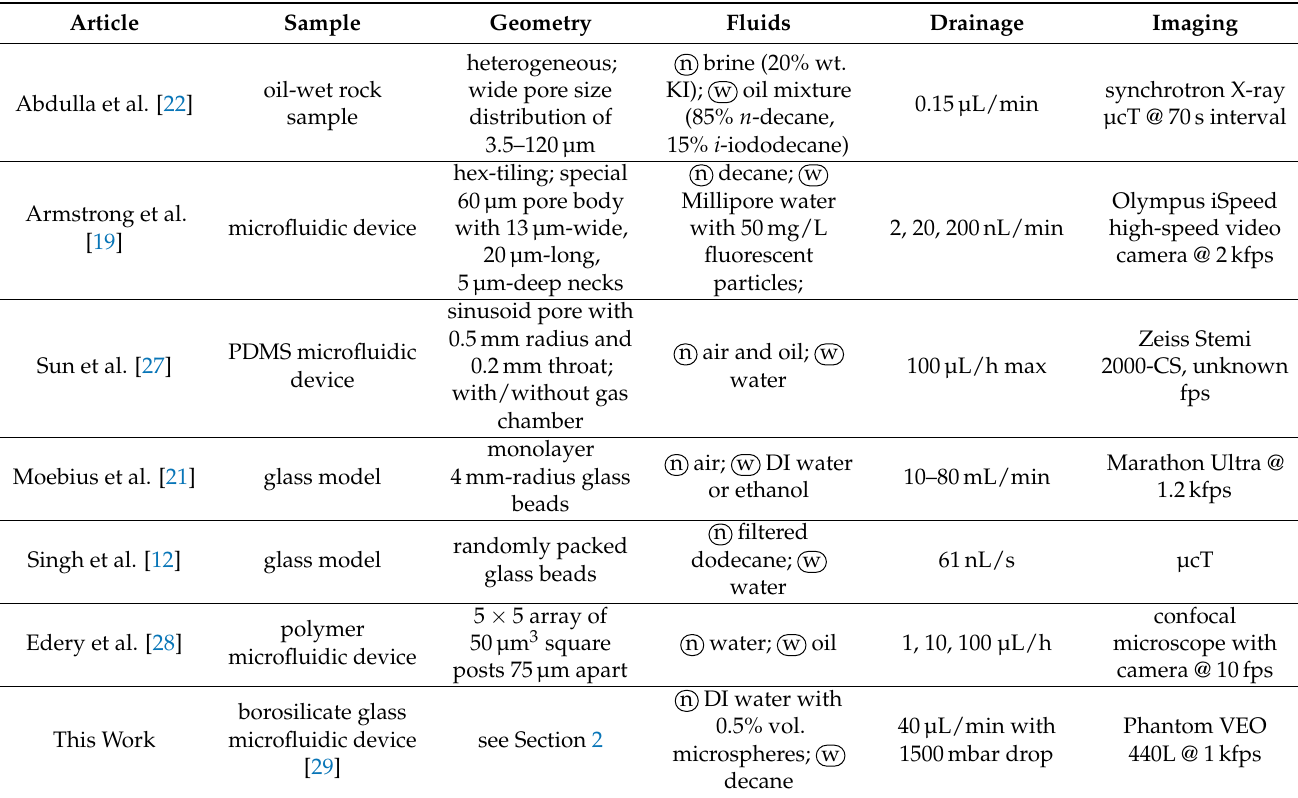
Table 1. Summary of existing literature reporting experiments similar to this